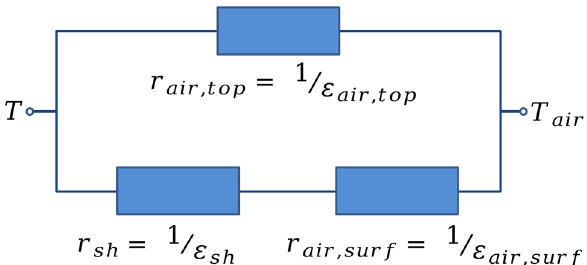
Figure 2. Schematic representation of the equivalent circuit employed to the obtainment of the effective thermal conductance, taking into account the conduction and convection processes contributing to the energy exchange between suspension and environment. Here, we represent r air , top = 1 /ǫ air , top as the thermal resistance of the air at the interface sample/air, r air , surf = 1 /ǫ air , surf as thermal resistance associated to the convection of the air on the outer surface of the sample holder, and r sh = 1 /ǫ sh as thermal resistance of the sample